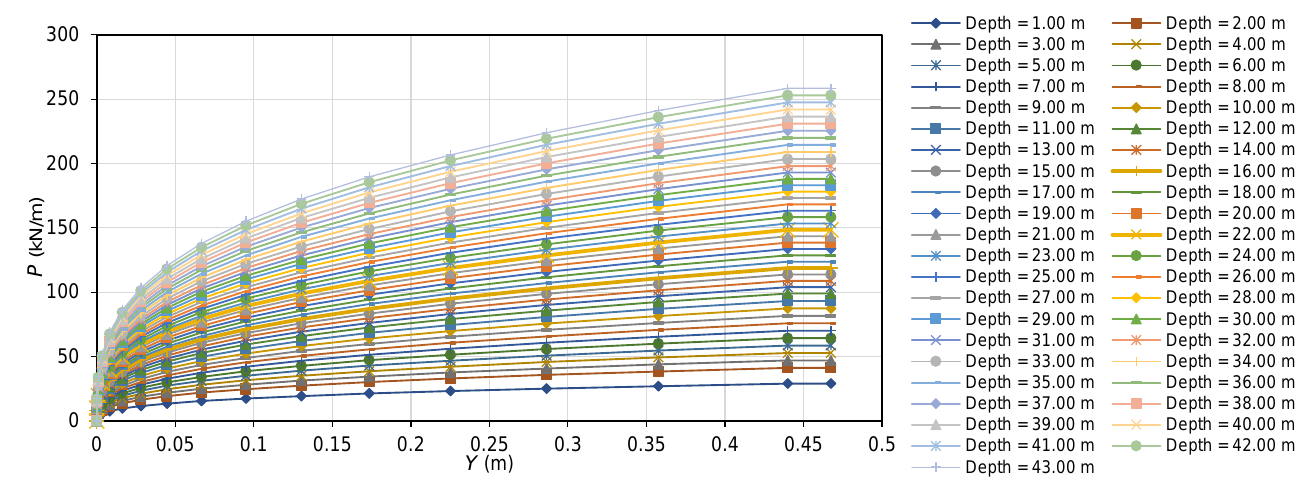
Figure 7. P-Y curves for Pile 2 (Ø 1100 mm).